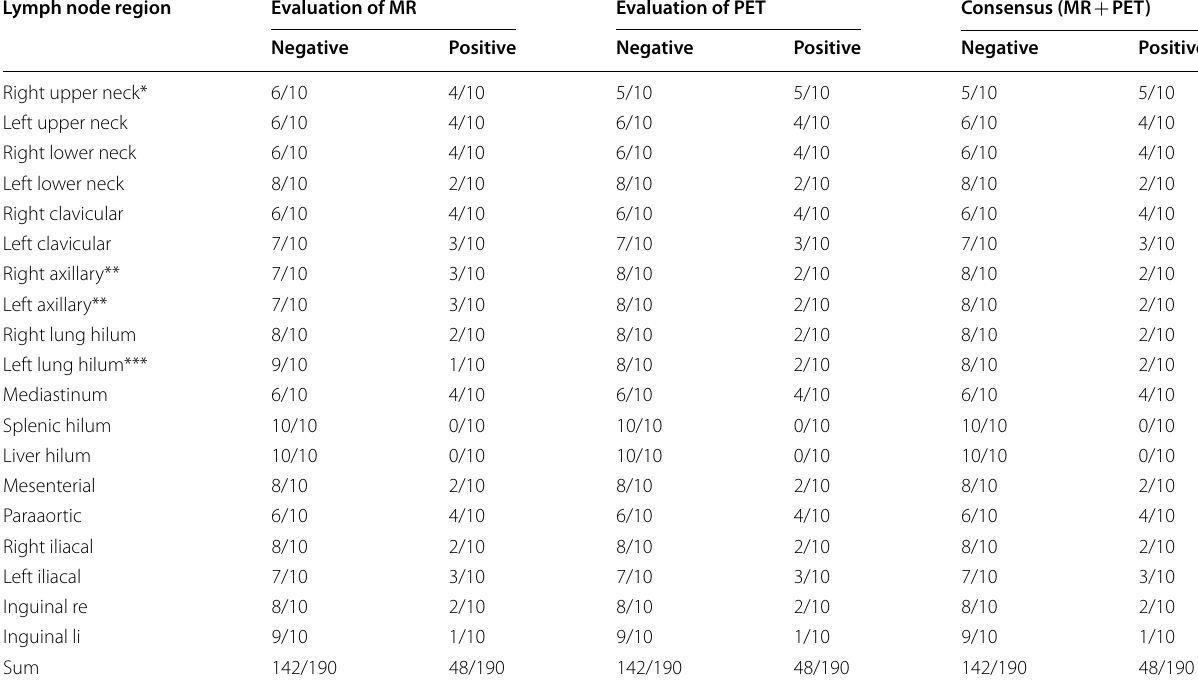
Table 2 Lymph node regions separated by imaging modality